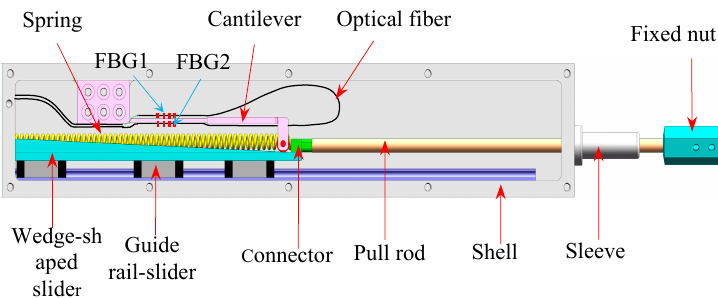
Figure 2. Structure of the proposed sensor.